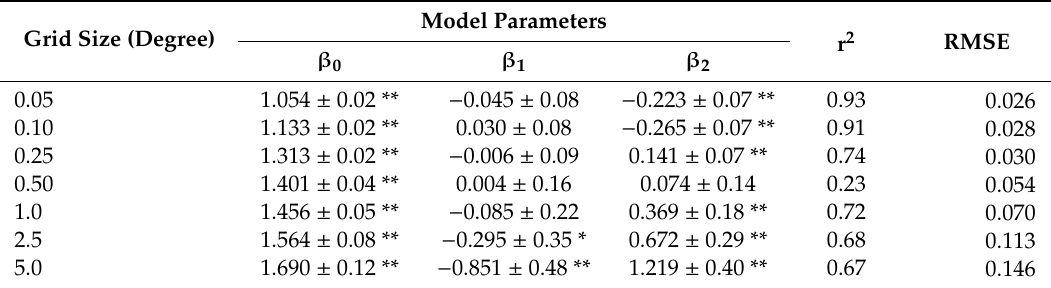
Table 1. Best-fitted models for VIIRS to MODIS FRP ratio as a function of MODIS VZA at seven grid sizes.